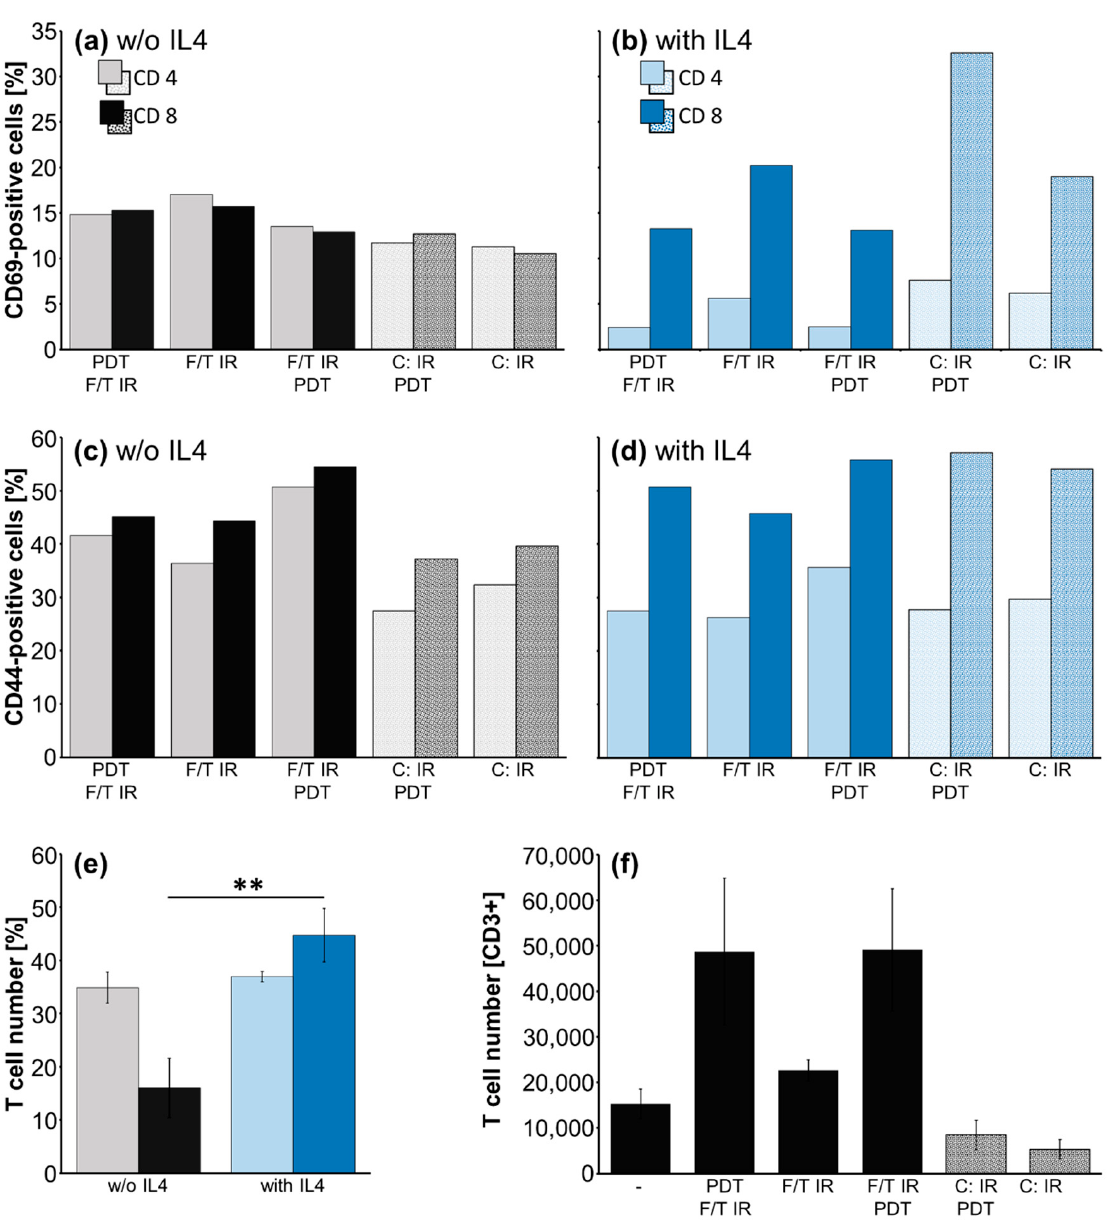
Figure 4. Induction of T-cell activation markers and proliferation. ( a – d ) Effect of lysate and cell antigen preparation and addition of IL4 on CD69 ( a , c ) and CD44 ( b , d ) T-cell activation markers in CD4- and in CD8-positive T cells of one representative experiment; ( e ) Effect of IL4 on CD4 and CD8 T-cell numbers, mean of five preparation groups ± SEM, **, p ≤ 0.01; ( f ) T-cell number after priming with DCs pulsed with indicated antigen preparations including LPS, or (-) LPS only, mean ± SEM, n = 2 ( e , f ).